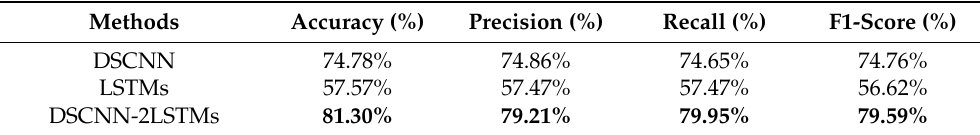
Table 6. Ablation Experiments for Five-Class Classification Task Recognition.